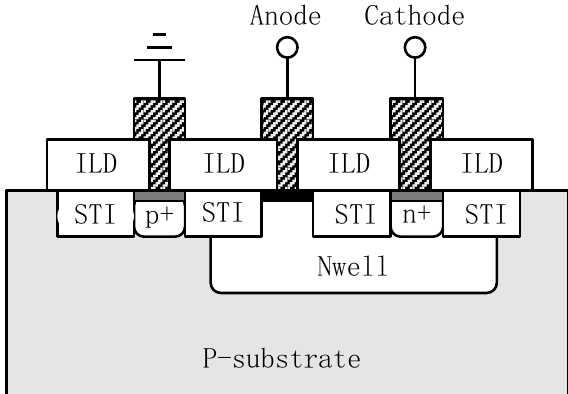
Figure 1. Cross section of the Schottky barrier